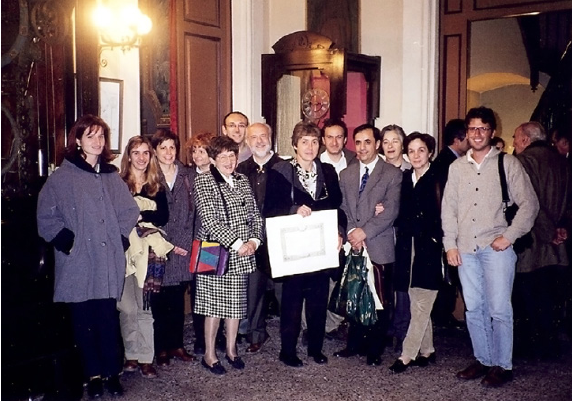
Fig. 5. – Marta Estrada in November 2000, the day when she be- came a member of the Royal Academy of the Sciences and the Arts of Barcelona, accompanied by several colleagues at the ICM. From left to right: M. Sala, L. Arin, C. Marrasé, D. Vaqué, E. Saiz, M. Alcaraz, A. Calbet, C. Pedrós-Alió, D. Blasco, C. Enríquez de Sala- manca and M. Latasa. Feli, Marta’s mother is next to